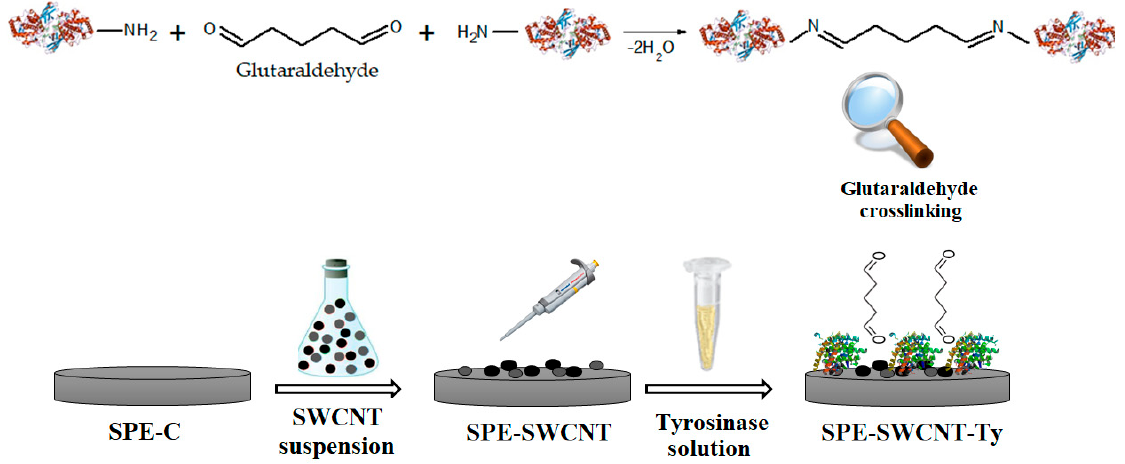
Figure 14. Preparation process of the tyrosinase biosensor supported on a carbon-based screen-printed electrode.